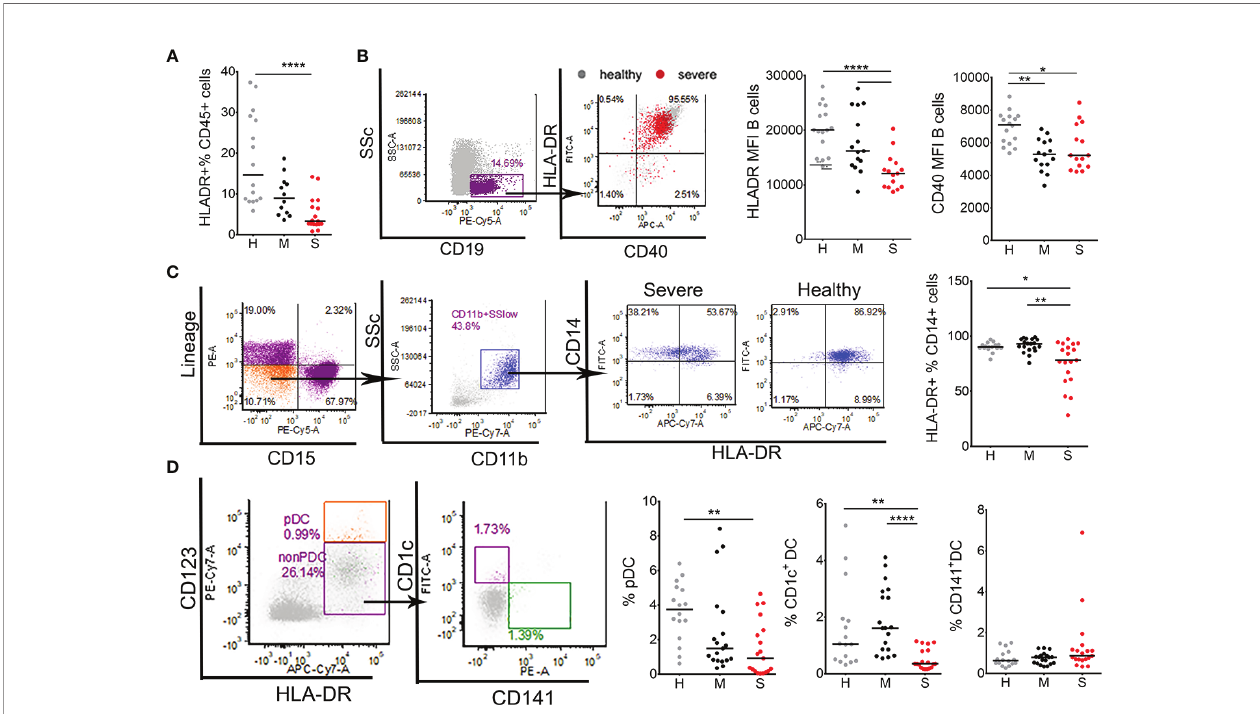
FIGURE 3 | Characterization of antigen presenting cells in coronavirus disease (COVID)-19 patients and healthy donors. (A) The percentages of total HLA-DR + cells within CD45 + leukocytes were obtained by fl ow cytometry in healthy donors (H, n=16), mild (M, n=12), and severe (S, n=19) COVID-19 patients. (B) The expressions of HLA-DR and CD40 were analyzed on B cells gated from PBMC as SSc low CD19 + cells. CD40/HLA-DR dot-plot represent an overlay of fl ow cytometry data from one healthy donor (gray) and one severe patient (red), and the summarized results from 16 healthy donors,15 mild, and 15 severe patients are shown as mean fl uorescence intensity (MFI). (C) HLA-DR expression on total monocytes was analyzed after gating these cells from CD45 + WBC as linage (lin) - (CD3 - CD7 - CD19 - CD56 - CD123 - Glycophorin A - ) CD15 - CD11b + CD14 + cells. Representative CD14/HLA-DR dot-plots are shown from one severe patient and one healthy donor, and the summarized results on the percentage of HLA-DR + cells of total CD14 + cells is shown. (D) Blood DC subsets were analyzed from monocytes region of PBMC as the percentage of pDC (HLA-DR + CD123 hi ), CD1c + DC (HLA-DR + CD123 low/- CD1c + CD141 - ), and CD141 + DC (HLA-DR + CD123 low/- CD1c - CD141 + ). The summarized results are expressed as the percentage of gated cells within monocytes region. (C, D) Data from 16 healthy (H) donors, 19 mild (M), and 19 (S) severe COVID-19 patients are shown. *p < 0.05, **p < 0.01, ****p < 0.001 (Kruskal-Wallis test with Dunn ’ s